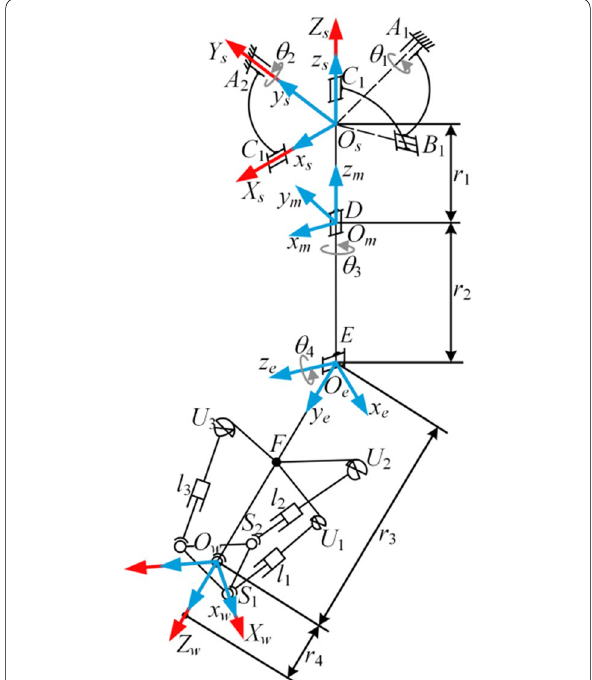
Figure 4 Schematic configuration of the serial-parallel hybrid